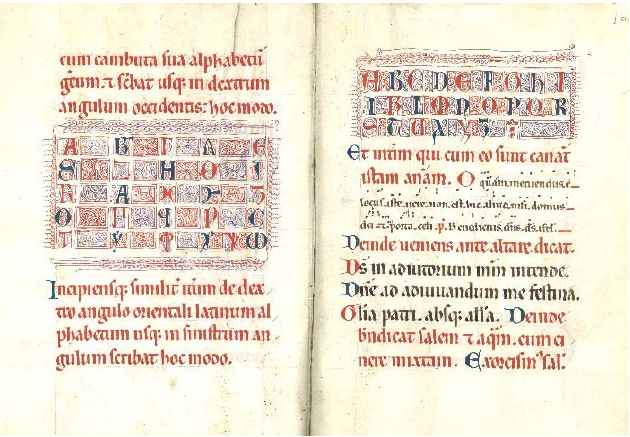
Figure 2. Double Latin ‐ Greek writing. BCT, Ms.39 ‐ 12, 101v ‐ 102r © Toledo Cathedral Archive.